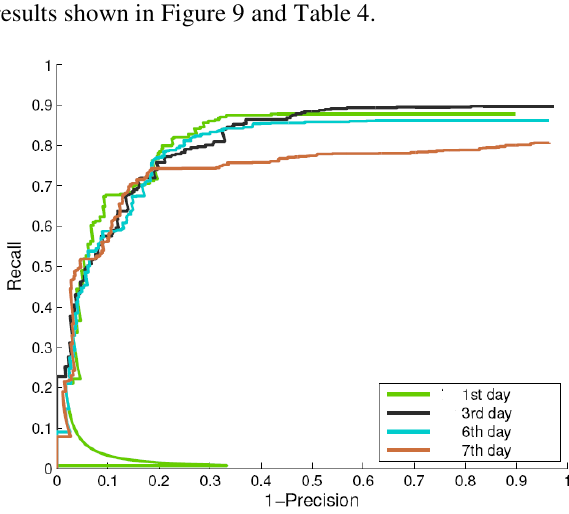
Figure 9 . RPC for the long-term data experiment Table 4. The Recall and Precision Comparison